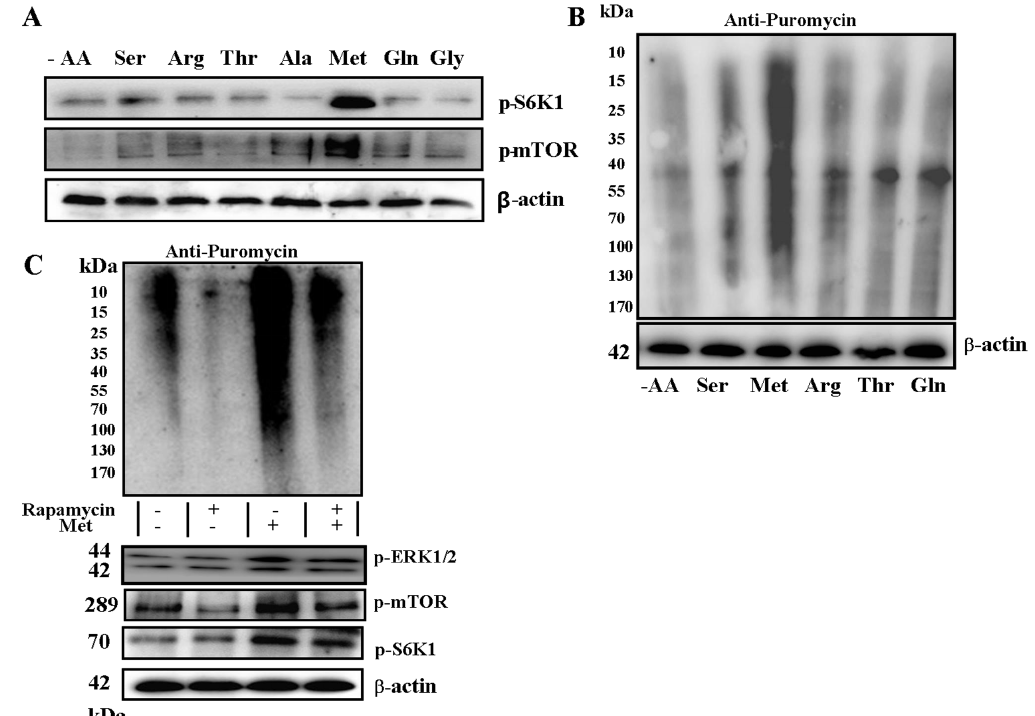
Figure 2. Met activates ERK1/2 and mTORC1 in C2C12 cells. Serum-starved C2C12 cells in KRBH were treated with seven different kinds of AA for 60 min. Immunoblots were performed with the indicated antibodies ( A ); Serum-starved C2C12 cells were stimulated with or without AA (Ser, Met, Arg, Thr, and Gln) and 20 nmol/L Rapamycin for 60 min, and rates of protein synthesis were measured with the SUnSET technique described in Materials and Methods ( B ); Immunoblots were performed with the indicated antibodies ( C ). “+” means to add, “-” means not to add. Results were represented as mean ±